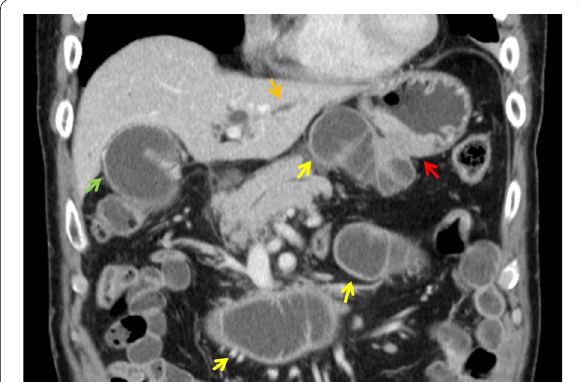
Fig. 1 Abdominal contrast-enhanced computed tomography at initial presentation. The anastomosis site of the gastrojejunostomy (red arrow) was thickened. In addition to the afferent loop (yellow arrows), the common bile duct, bilateral intrahepatic bile ducts (orange arrow), and gallbladder (green arrow) were also significantly